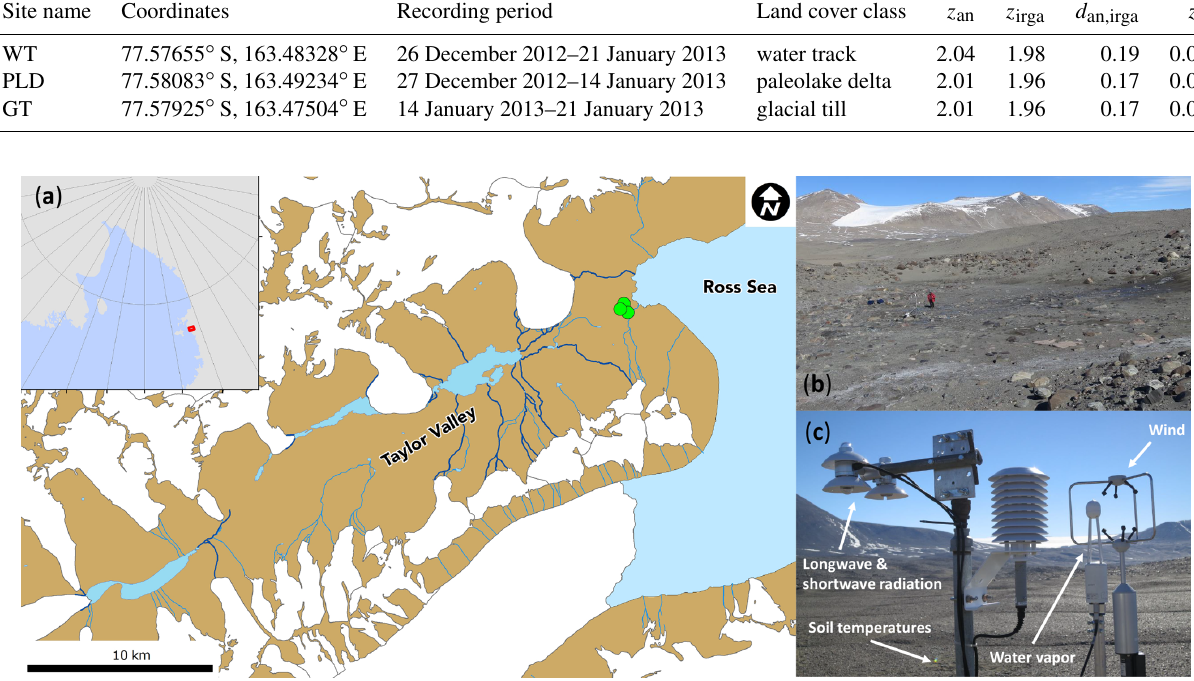
Figure 2. Location of the three study sites near Ross Ice Shelf in lower Taylor Valley, with inset map showing location of the sites on the Ross Sea, gridded by 10 ◦ latitude–longitude lines (a) . WT site (water track) (b) . PLD site (paleolake delta) with eddy-covariance and surface energy balance station (c)